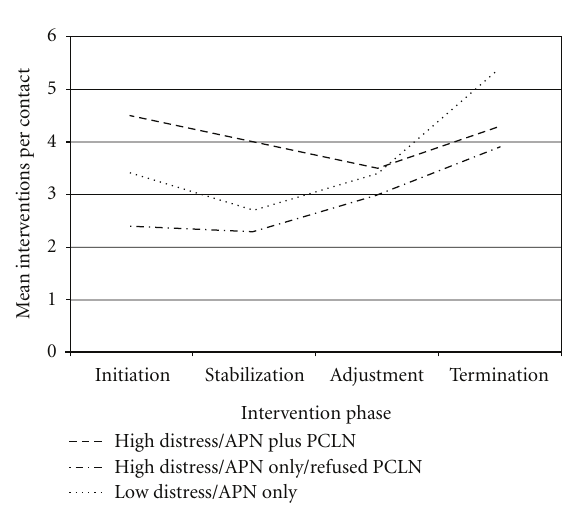
Figure 4: Mean interventions per contact per intervention phase for each subsample: psychosocial